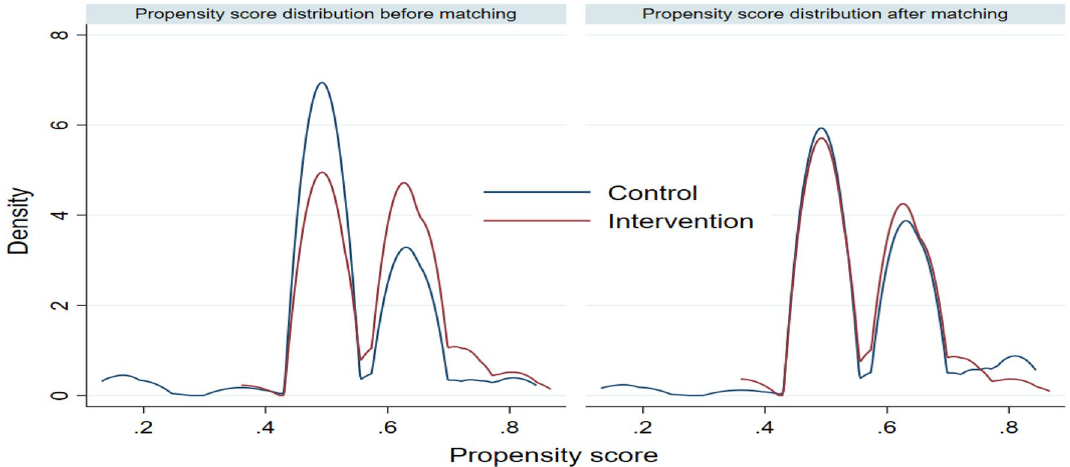
Figure 1. Kenel density of the propensity scores before and after matching for intervention and control populations.